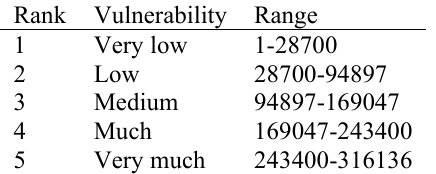
Table 8. Vulnerability and its ranking based on